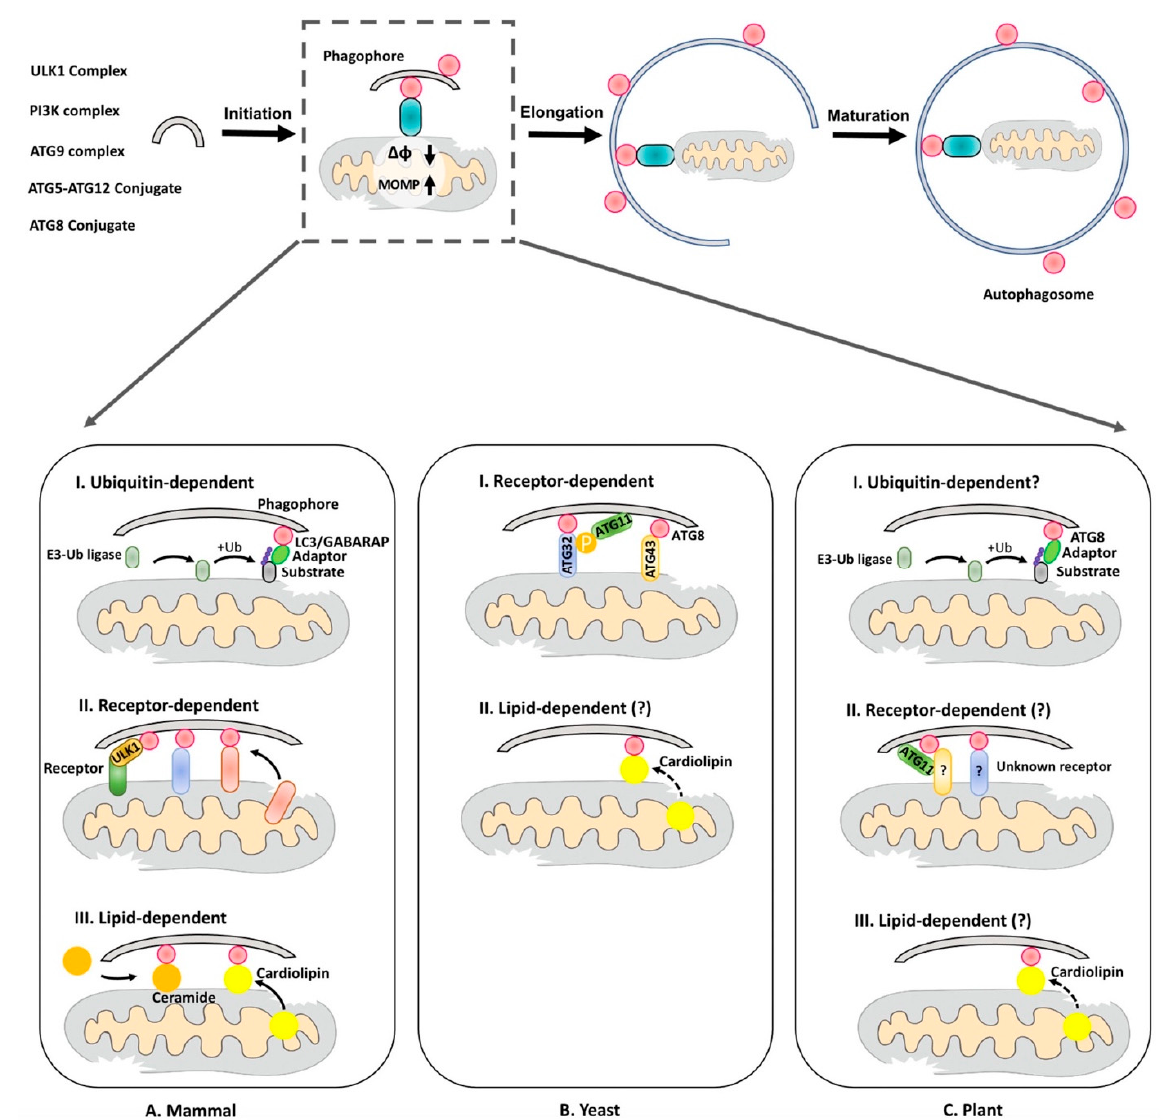
Figure 1. Mitophagy pathways in different organisms. Upon stress damage, the ΔφΜ of the mitochondrion is